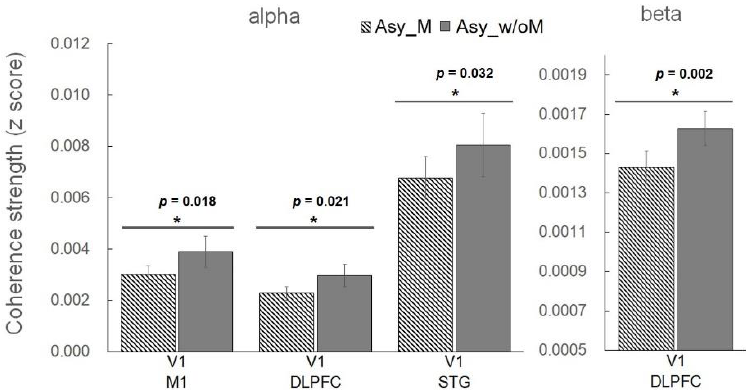
Figure 4. The statistical results show that functional connectivity of V1-M1 (alpha band), V1-DLPFC (both alpha and beta bands), and V1-STG (alpha band) in the Asy_M condition was significantly reduced compared with the Asy_w/oM condition.